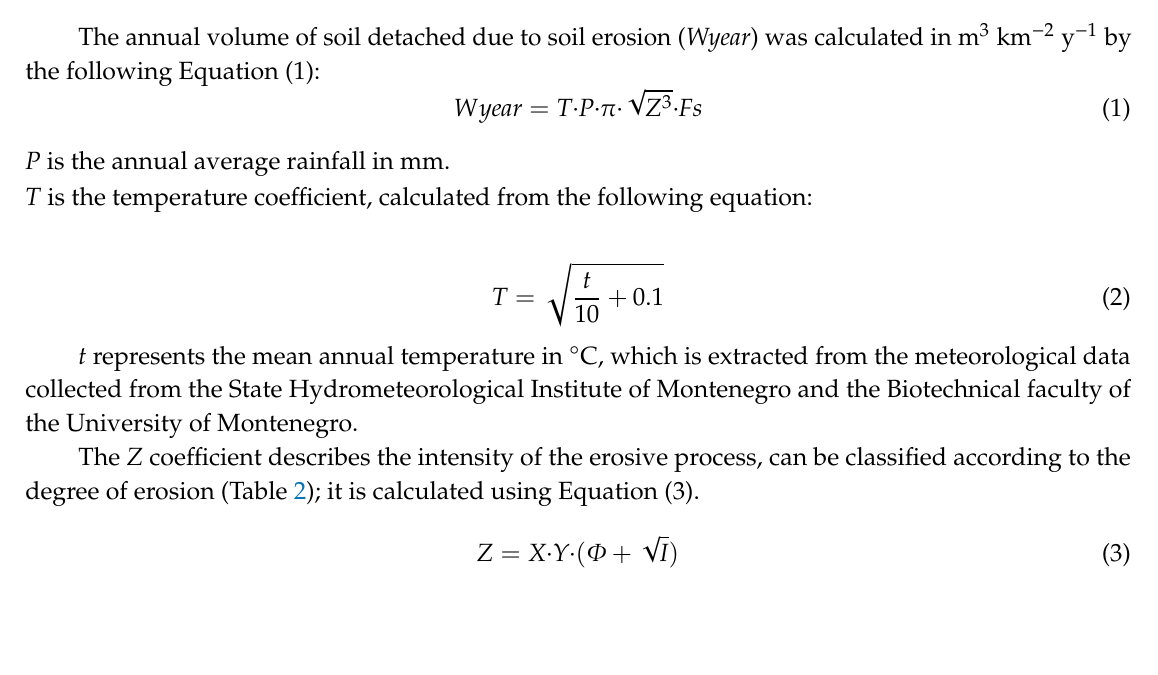
Figure 2. IntErO model Flow chart with the details on inputs needed (27) and basic outputs (22).